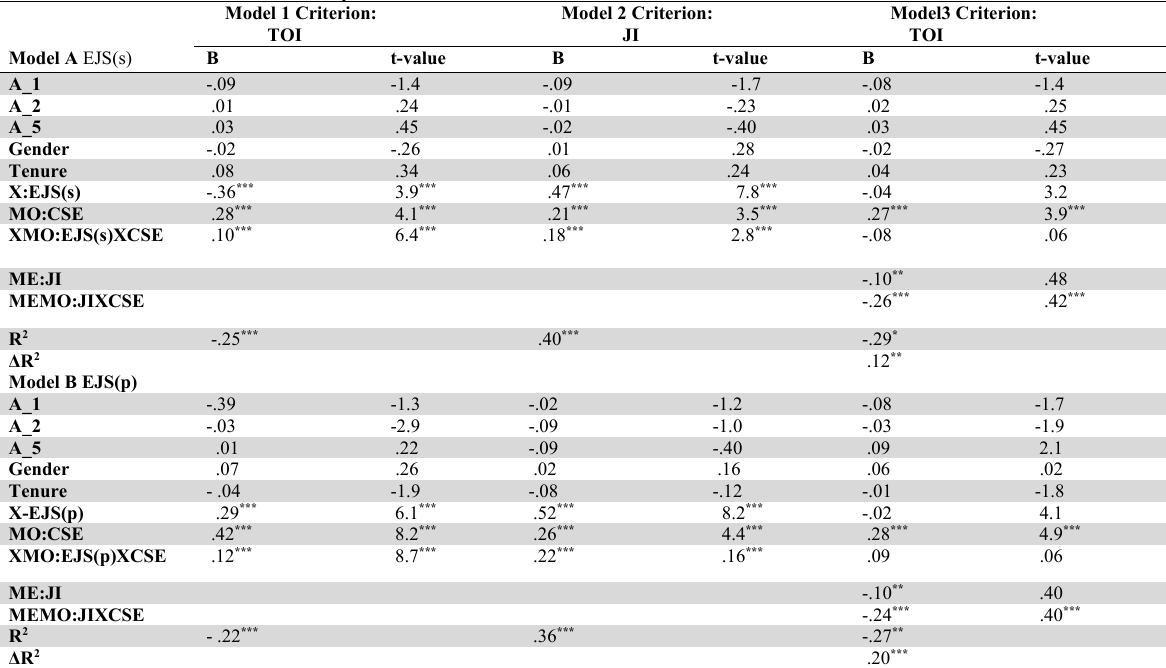
Results of moderated mediation analyses of Flexible Work Time for TOI